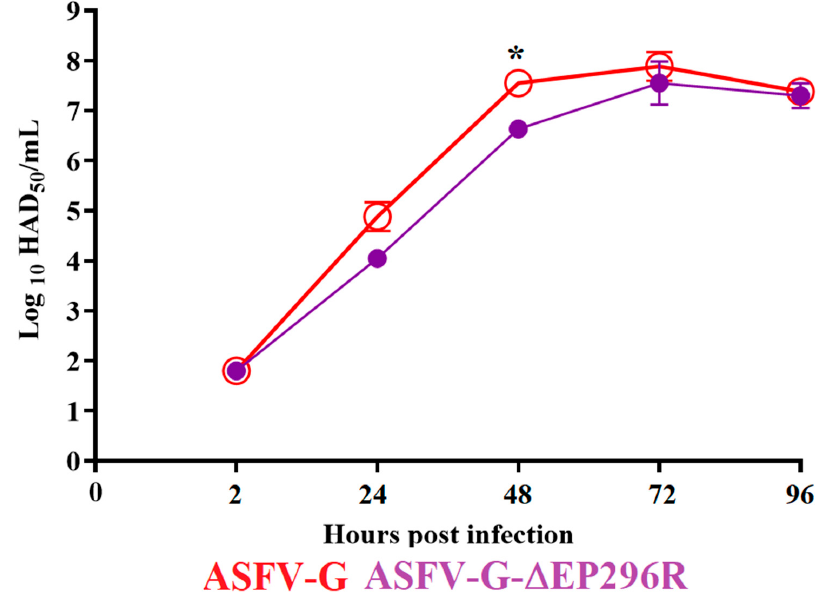
Figure 5. In vitro growth kinetics in primary swine macrophage cell cultures for ASFV-G- ∆ EP296R and parental ASFV-G (MOI = 0.01). Samples were taken from three independent experiments, at the indicated timepoints, and titrated in swine macrophages. Data represent the means and standard deviations of three replicate wells. Sensitivity using this methodology for detecting virus was ≥ log 10 1.8 HAD 50 / mL . Unpaired t -test with Welch correction using the two-stage step-up (Benjamini, Krieger, and Yekutieli) method was conducted to assess statistical differences in viral yields between ASFV-G and ASFV-G- ∆ EP296R at different hours post infection. Significant differences between viruses were found at 48 h (*) post infection. The significance of this discovery was evaluated using the false discovery rate method (FDR), with q -values <0.05 considered significant.